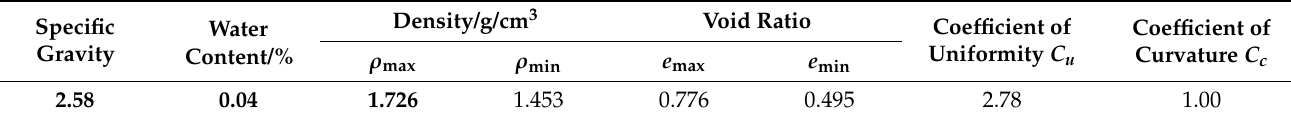
Figure 3. The distribution curves of the sand particle. Table 2. Fundamental material properties of the sand.